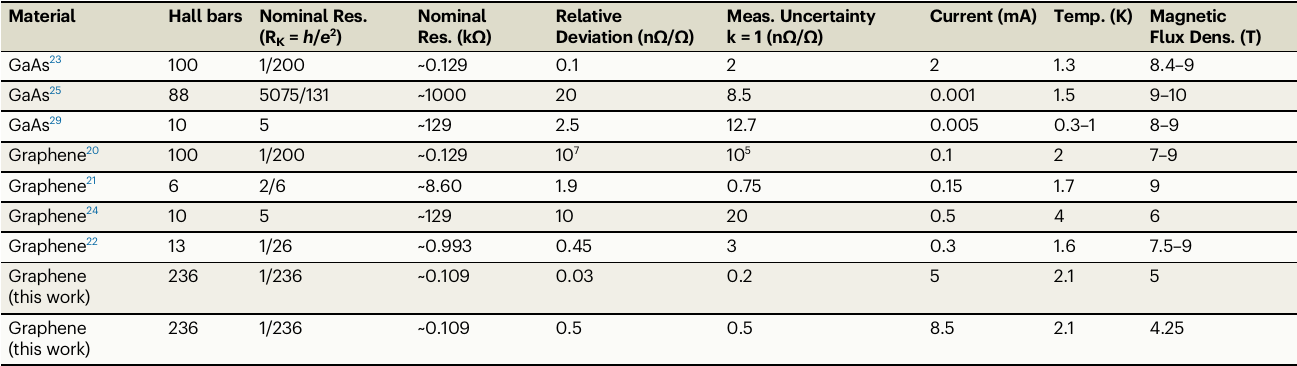
Table 1 | Comparison between different quantum Hall arrays Material Hall bars Nominal Res. (R K = h / e 2 )